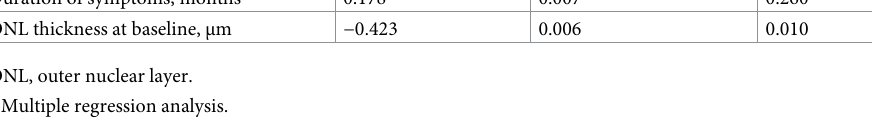
association between baseline ONL thickness and the presence of metamorphopsia at 12 months after RFPDT and observed a significant difference between the two groups in the pres- ence of metamorphopsia at 12 months after RFPDT ( P < 0.001) (Table 7).